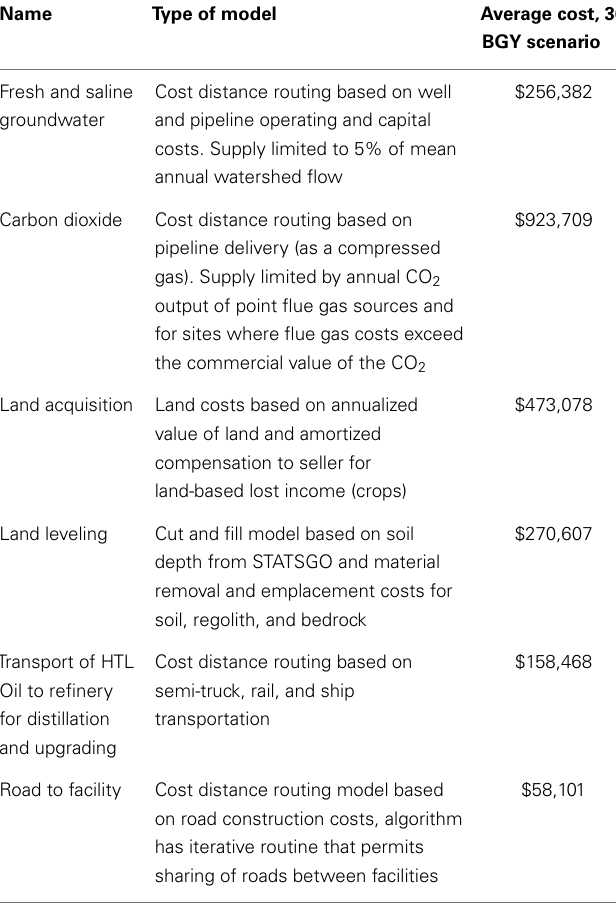
RD target and their locations ( Figure 1 ) illustrated the significant impactof strainselectionandperformance.Predictedgrowthrates ( Figure 2 ) for Sphaeropleales were nearly 60% higher than